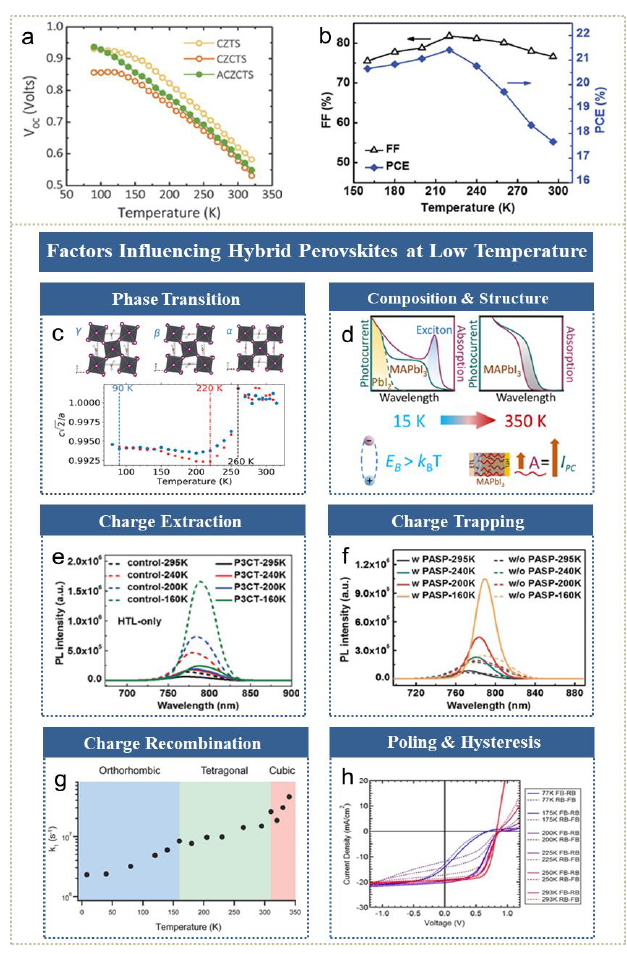
Figure 7. Low-temperature enhanced phenomena on solar cells. ( a ) Temperature-dependent V OC of CZTS-based solar cells (adapted from [57], with permission from Wiley-VCH, 2018). ( b ) Cooling- enhanced PCE and FF of perovskite solar cells (adapted from [164], with permission from Wiley-VCH, 2019). ( c ) Phase transition (adapted from [39], with permission from Wiley-VCH, 2019). ( d ) Composi- tion and structure (adapted from [165], with permission from Wiley-VCH, 2018). ( e ) Charge extraction. ( f ) Charge trapping (adapted from [164], with permission from Wiley-VCH, 2019). ( g ) Recombination rate (adapted from [30], with permission from Wiley-VCH, 2015). ( h ) Poling and hysteresis (adapted from [166], with permission from the American Chemical Society,